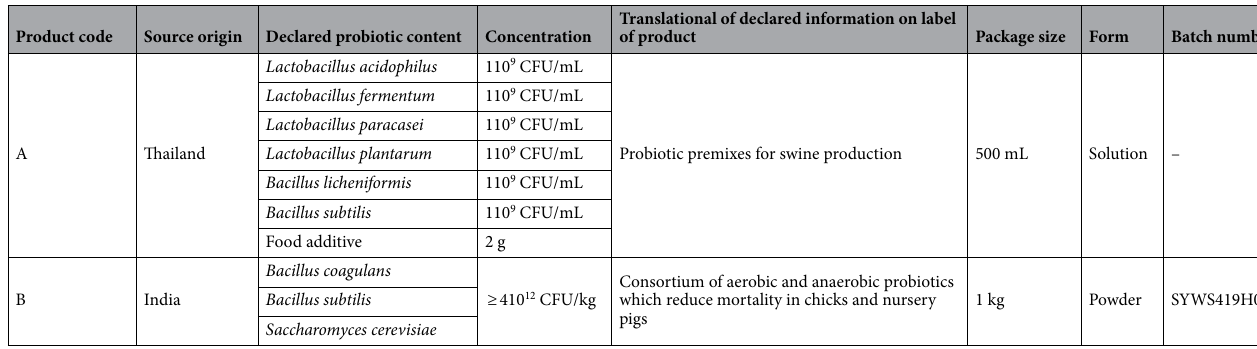
Table 1. Detail information of commercial probiotic feed-additives as declared on the package